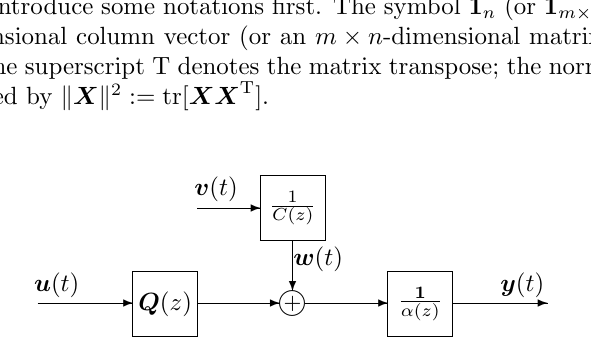
Figure 1. The considered multivariable CARAR-like